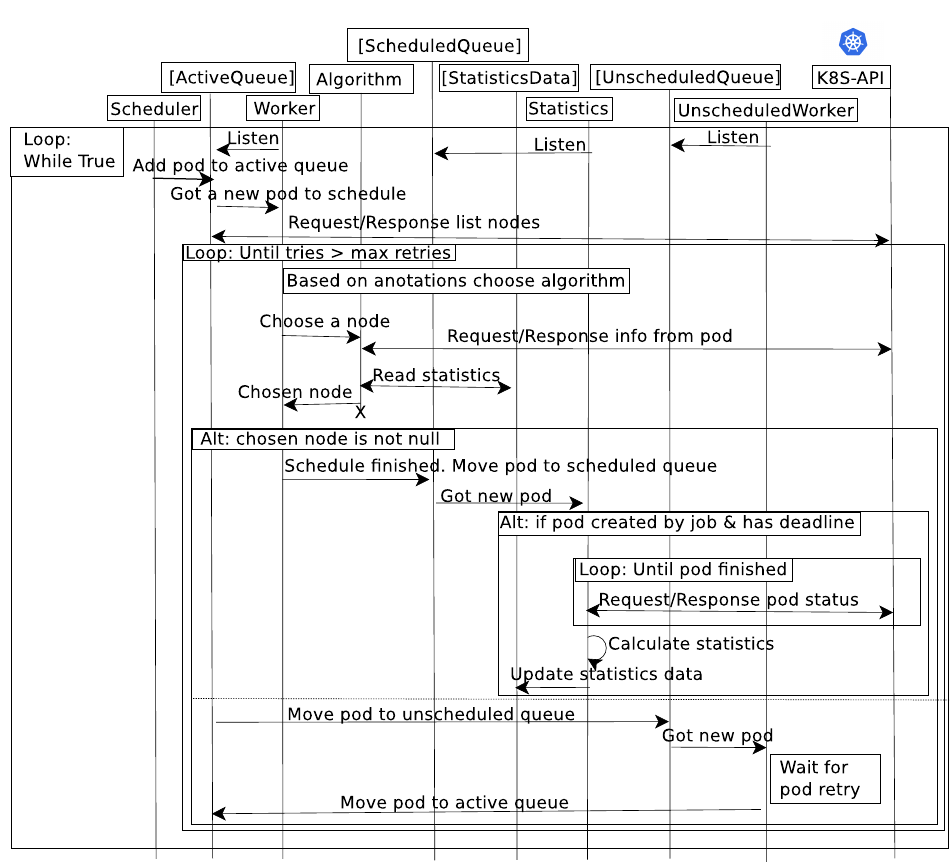
Figure 2. Sequence